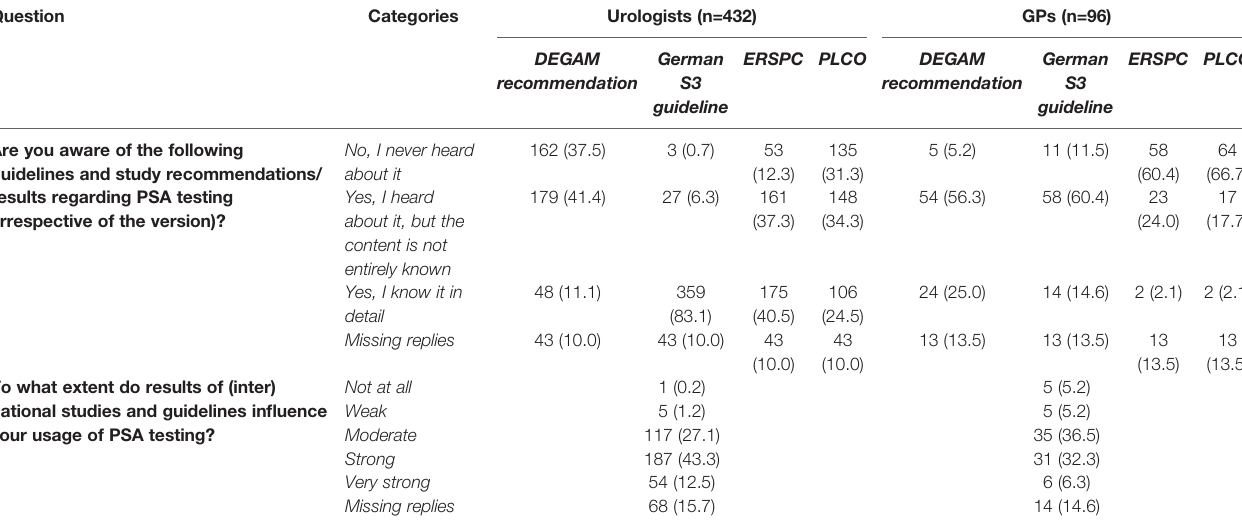
TABLE 2 | Awareness and in fl uence of guidelines and recommendations on prostate cancer by urologists and general practitioners [n (%)].